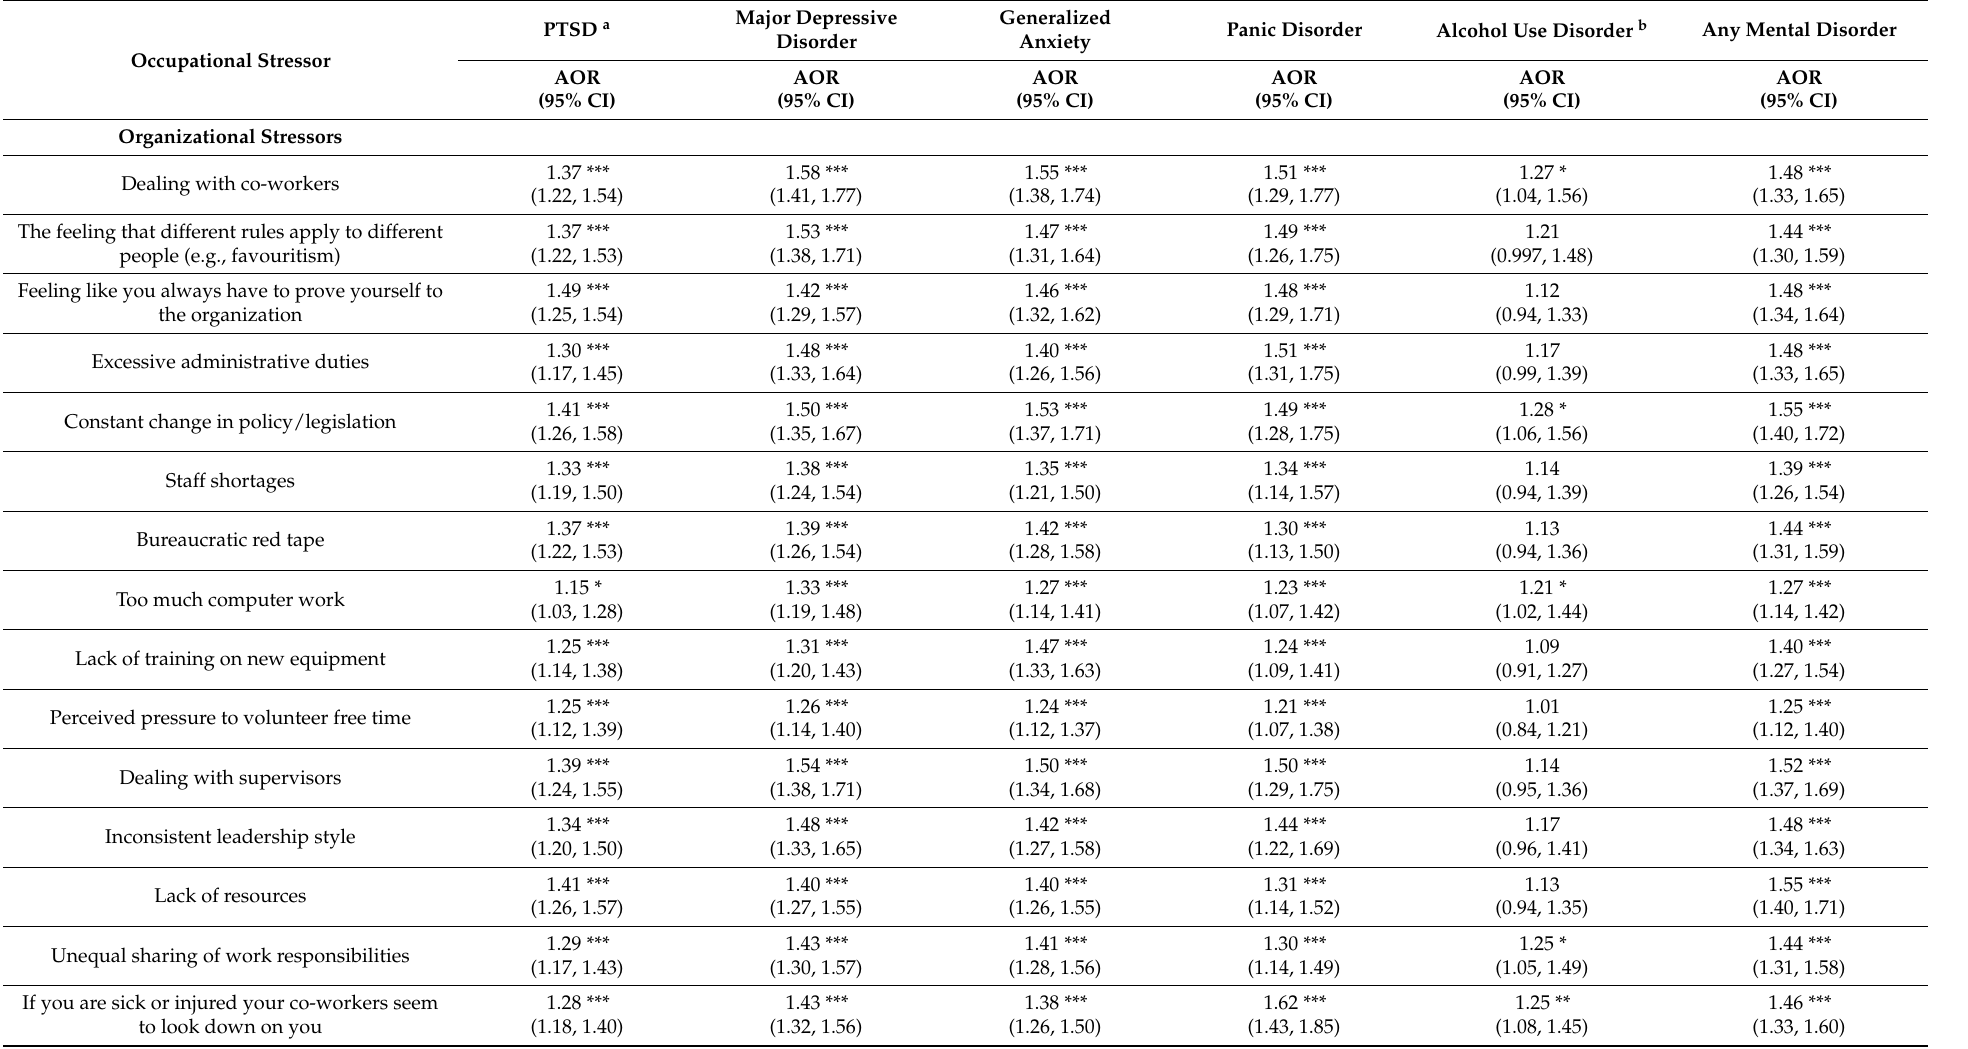
Table 3. Relationship between occupational stressors and positive mental disorder screens among correction workers in Ontario,